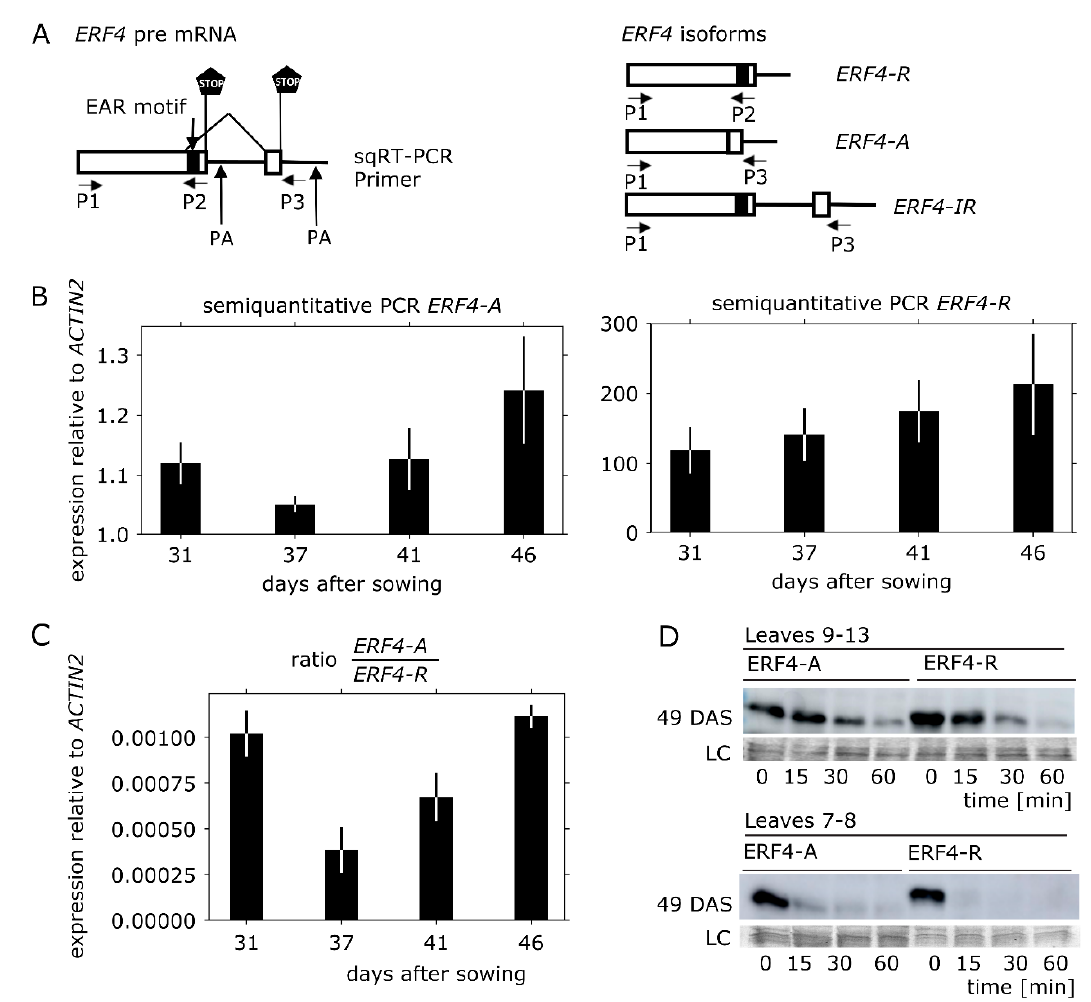
Figure 2. ERF4 isoform expression and protein stability. ( A ) Schematic illustration of ERF4 pre-mRNA with two different polyadenylation sites and primer binding sites for primer 1 (P1), primer 2 (P2) and primer 3 (P3), which were used for semi-quantitative reverse transcriptase PCR (sqRT-PCR) as described in [27]. Boxes denote exons, lines denote introns and untranslated regions, PA indicates alternative polyadenylation sites, black box indicates the repressing ERF-associated amphiphilic repression (EAR) motif. cDNA of the ERF4 isoforms is shown on the right side. ( B ) Results of the sqRT-PCR using RNA isolated from Col-0 plants at different developmental stages indicated in days after sowing (DAS). Graph shows expression of ERF4-A (36 cycles, 3 µ L cDNA) and ERF4-R (27 cycles, 2 µ L cDNA ) , which was quantified using ImageJ and is presented relative to expression of ACTIN2 . Error bars indicate ± SE, n = 3. ( C ) Ratio of ERF4-A to ERF4-R mRNA at different developmental stages ( D ) Cell-free protein degradation assay. 6xHIS-tagged ERF4-R (26.6 kDa) and ERF4-A (24.5 kDa) proteins were incubated in protein extract of young (No. 9 − 13) and middle old leaves (No. 7 and 8) for 0 − 60 min. Five plants were pooled for protein extraction and were harvested 49 days after sowing (DAS). Amido black staining of the upper part of the polyvinylidene difluoride (PVDF) membrane is shown as loading control (LC).